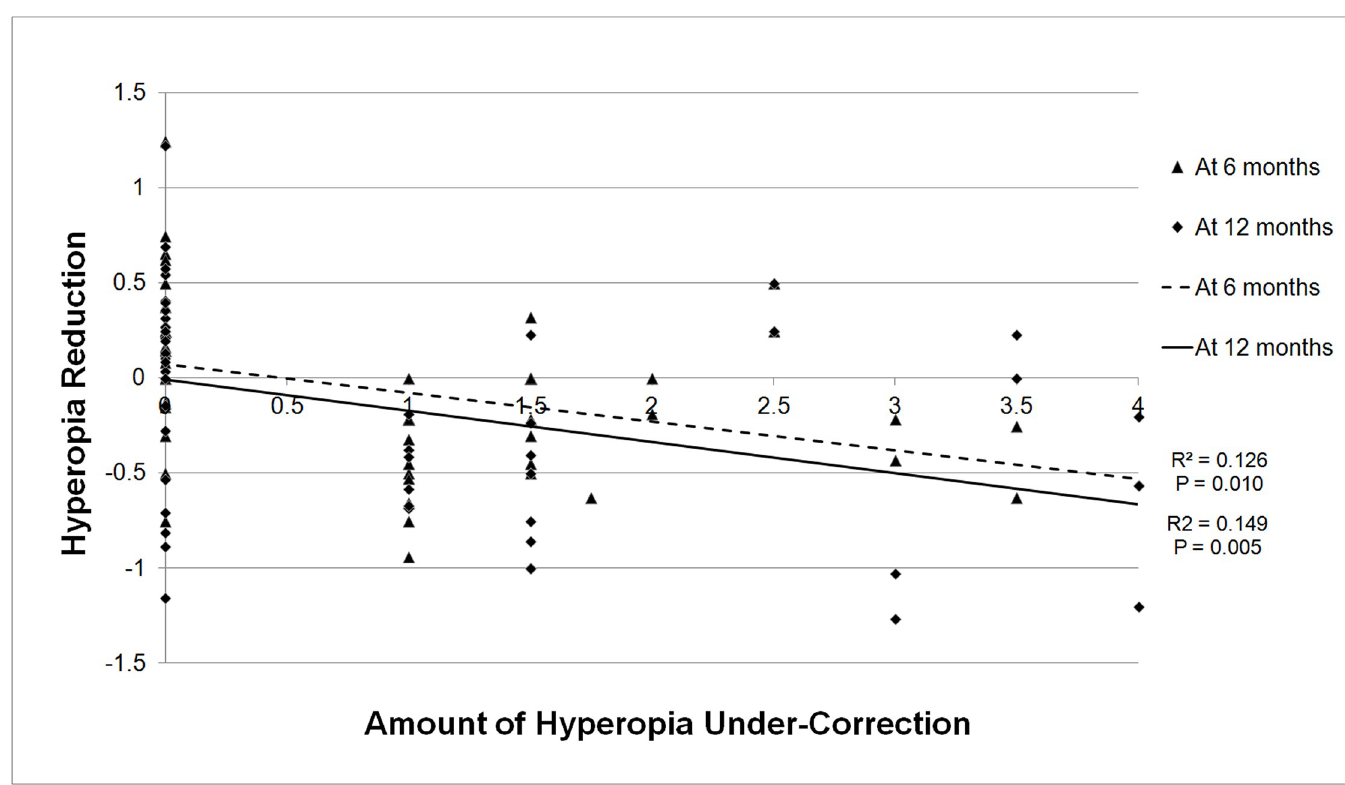
Fig 2. Correlation between the amount of hyperopia under-correction and hyperopia reduction.